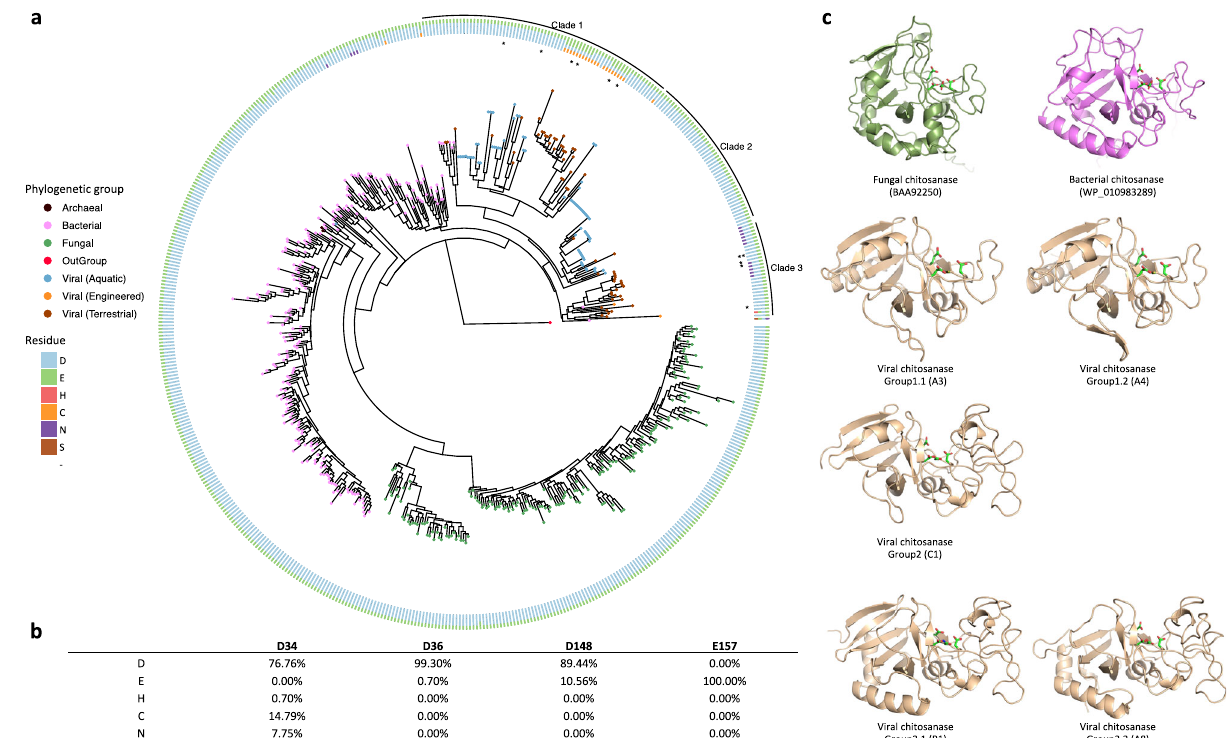
Fig. 1 | GH75 chitosanases detected across domains of life. a The phylogenetic tree with viral, fungal (green), bacterial (pink) and archaeal (black) chitosanases is rooted by a bacteriophage lysozyme (YP_006987285.1, red node). The tree leaves representing viral chitosanases are colored by habitat: aquatic (blue), engineered (orange), terrestrial (brown). The four key residues in the proposed active site are colorcodedandshowninthecircularringssequentiallywiththeresidueclosestto the N-terminal position in the innermost ring. The viral chitosanases selected for